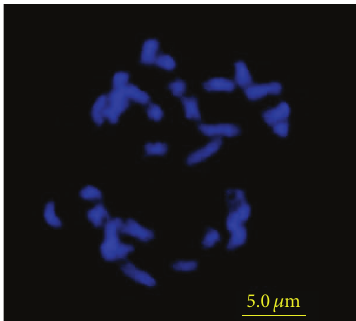
Figure 1: Root tip squash showing chromosomes from the F1 hybrid (chromosome number of 29).